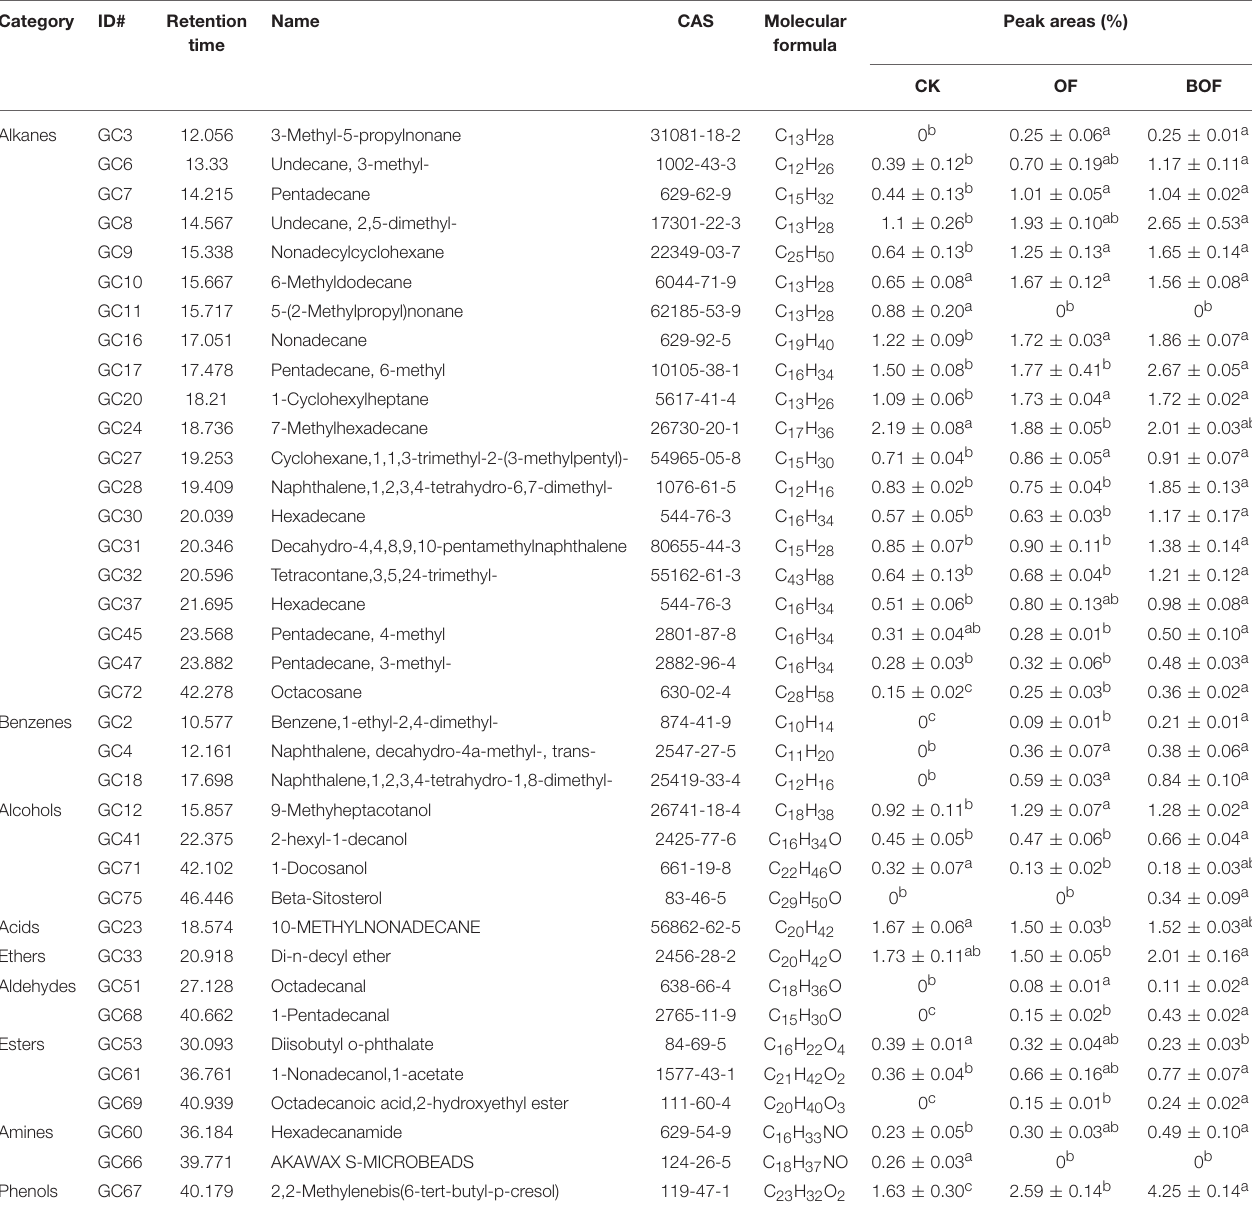
TABLE 1 | Relative abundances of identified soil chemistry by different fertilization